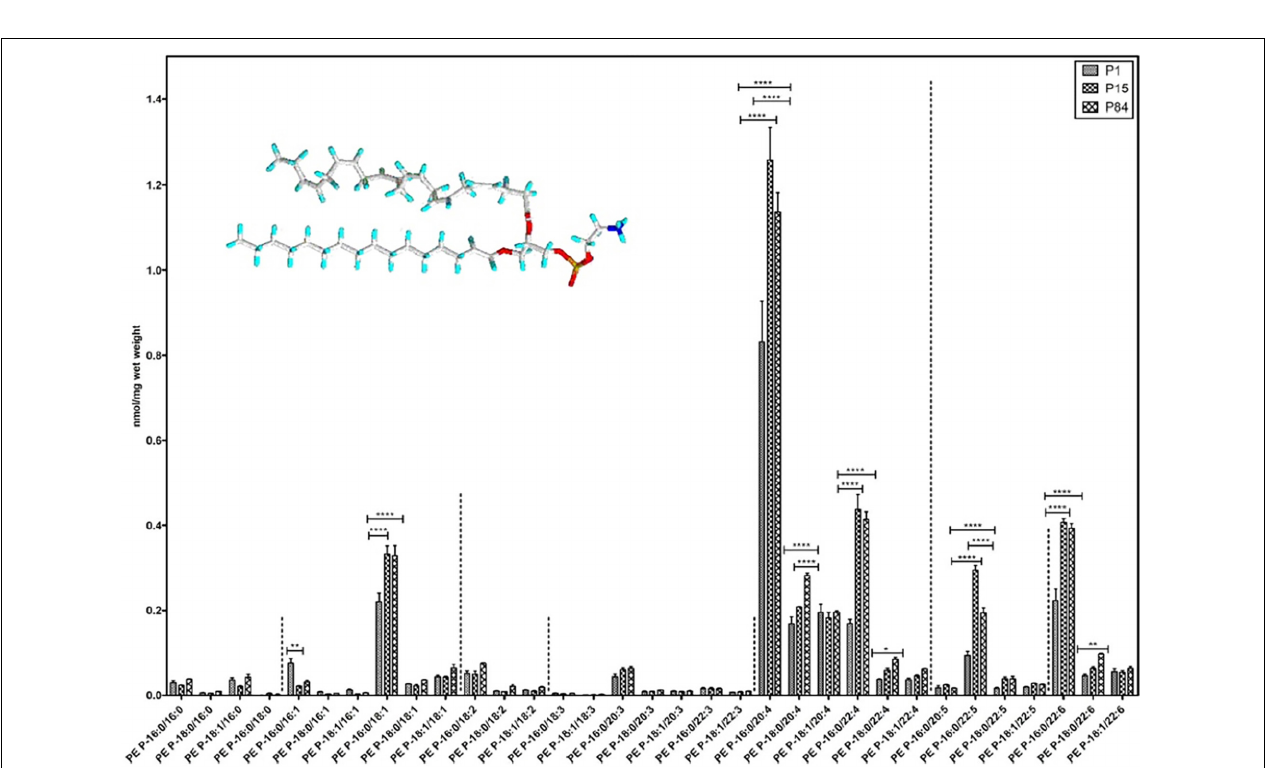
FIGURE 11 | Composition of individual phosphatidylethanolamine PE-based plasmalogen (PE-P) lipid species during postnatal development of mouse lung. High contents of 20:4, 22:6, 22:5, and 22:4 plasmalogen (PE-P) derivatives are detected. PE P-16:0 (sn-1) plasmalogens are present in higher amounts in all 4 groups of ethanolamine plasmalogens, whereas PE P-18:0 and PE P-18:1 account for smaller amounts. Values are represented as nmol/mg wet weight. Reprinted from Karnati et al. (2018) with permission. Statistical significance (* , ** , ***): p -values < 0.05 (significant), < 0.01, < 0.001 (highly significant).